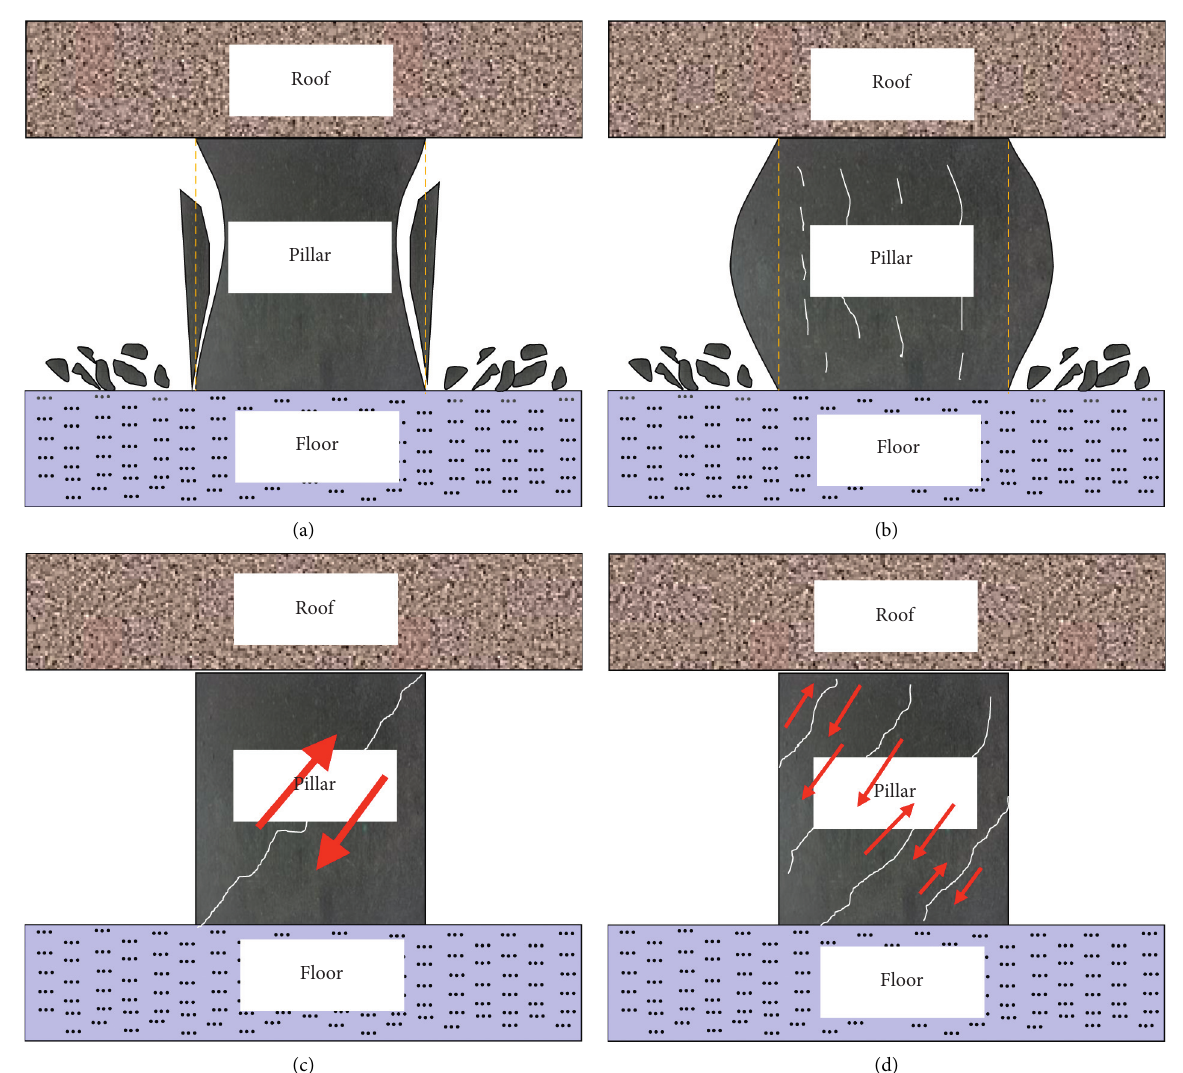
Figure 8: Diagram of pillar failure modes: (a) lateral spalling; (b) splitting inside pillar; (c) compression-shear failure; (d) joint